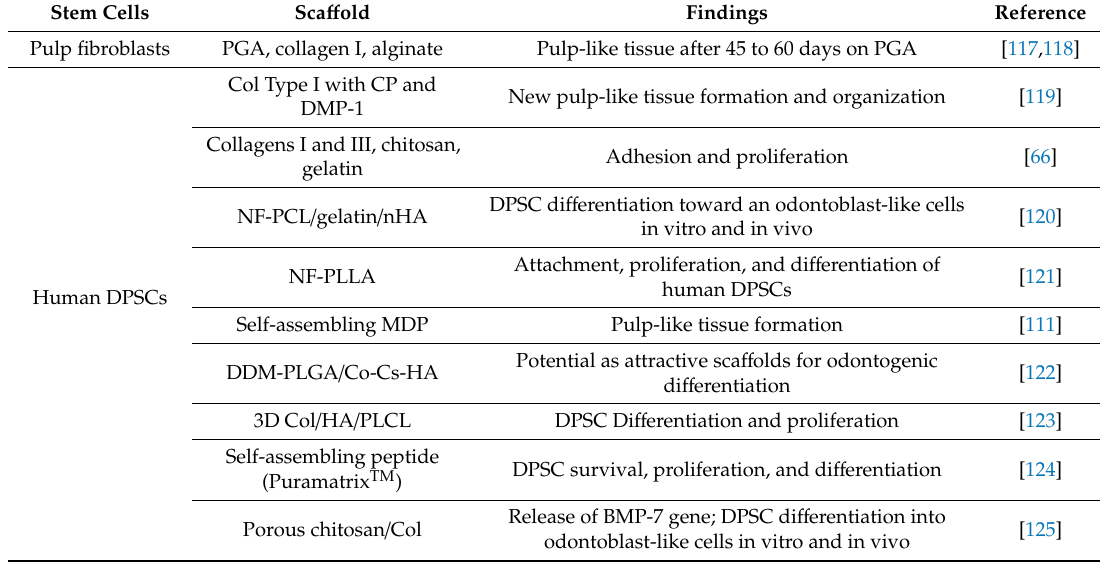
Table 1. Summary of recent biomedical approaches in regenerative endodontics (adapted from work in